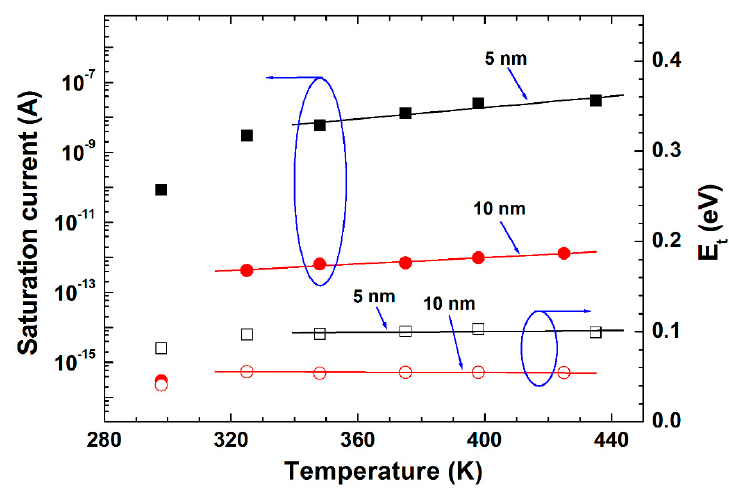
Coatings 2020 , 10 , x FOR PEER REVIEW 7 of 12 Figure 6. Tunneling saturation current and barrier energy vs. temperature. Figure 6. Tunneling saturation current and barrier energy vs. temperature.